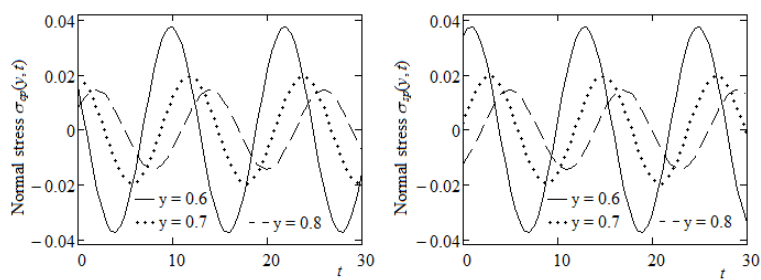
Figure 9. Time variations of the normal stresses σ cp ( y , t ) and σ sp ( y , t ) for Re = 100, We = 1, ω = π /12, α = 0.8 and increasing values of y .